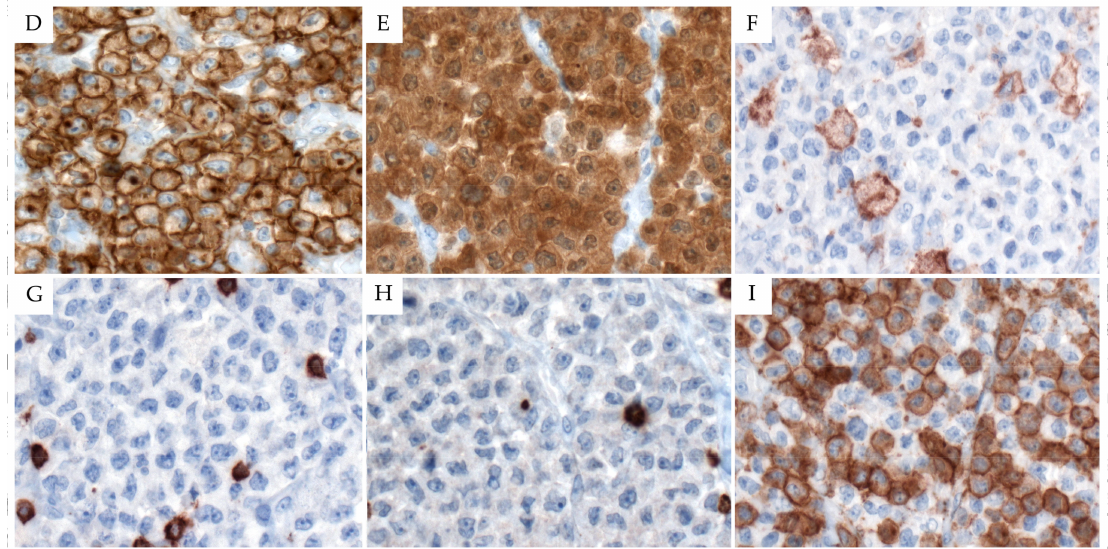
Figure 1. Morphological and immunohistochemical findings in ALK+ ALCL. ( A ) Tumor cells infiltrating the sinuses displaying a cohesive pattern (H&E stain, 100 × ); ( B ) The large neoplastic cells are relatively monomorphic, showing abundant eosinophilic cytoplasm and pleomorphic nuclei and frequent apoptotic bodies (H&E stain, 400 × ); ( C ) A “hallmark cell”, displaying an eccentric horseshoe-shaped nuclei with two nucleoli and prominent Golgi area (H&E stain, 630 × ); ( D ) The tumor cells are strongly and uniformly positive for CD30 with a membranous and Golgi zone pattern; ( E ) Strong cytoplasmic nuclear and nucleolar ALK staining in the neoplastic cells is observed; ( F ) CD4 is positive in macrophages but negative in neoplastic cells. ( G , H ) CD3 and CD7 are positive in accompanying T cells but negative in the tumor cells. ( I ) CD5 is positive in the majority of the tumor cells (( D – I ), immunohistochemistry, 400 × ). Abbreviations: H&E: hematoxylin and